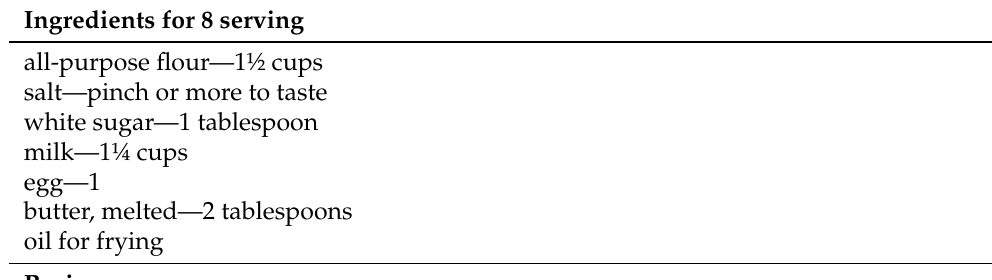
Table 3. Example: A recipe for